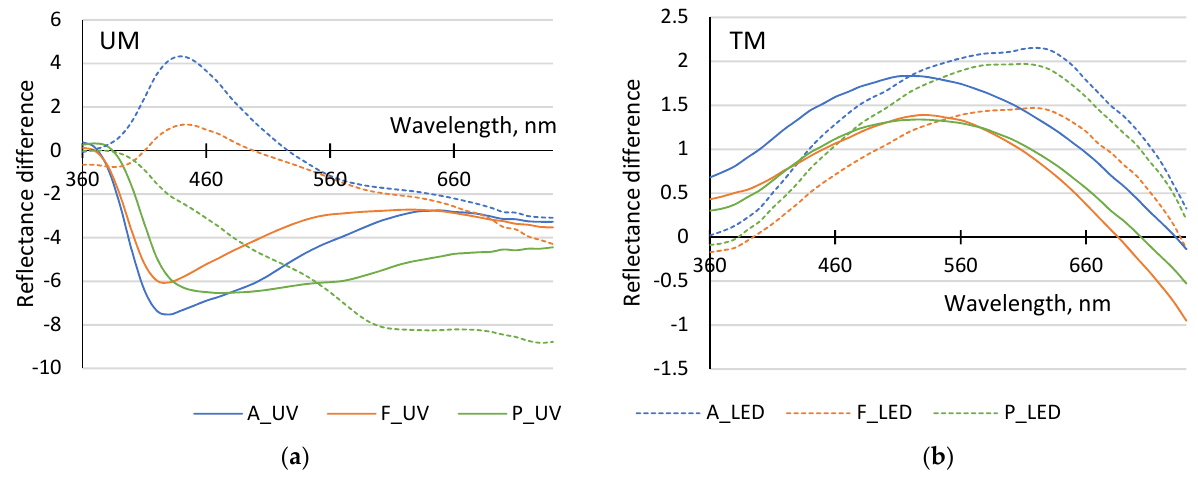
Figure 3. Reflectance difference spectra of unmodified ( a ) and thermally modified ( b ) of aspen (A), ash (F), and pine (P) due to exposure to UV radiation and LED lamps.